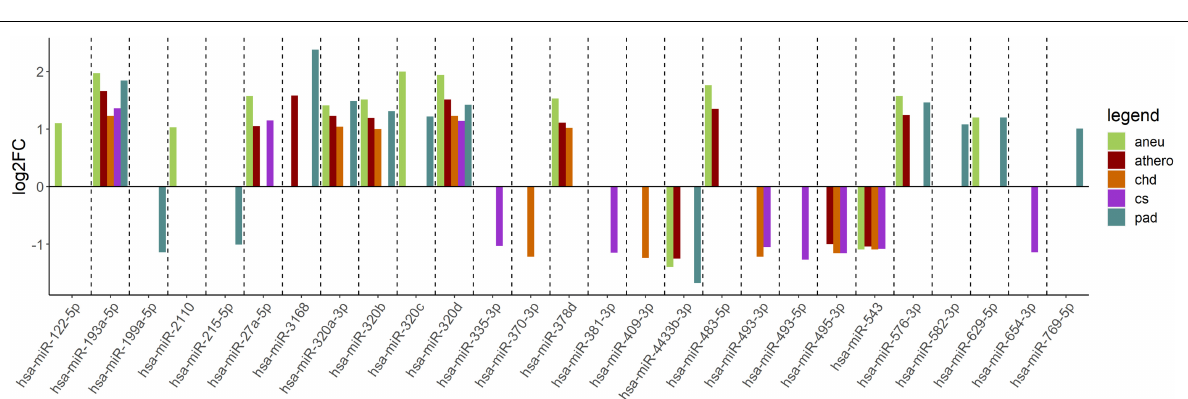
FIGURE 3 | Log2FC of summarized differentially expressed miRNAs from the comparison of each group vs. control. The log2FC is given on the y-axis. aneu = abdominal aneurysm, athero = atherosclerosis, chd = coronary heart disease, cs = carotid stenosis, pad = peripheral artery disease, log2FC = log2 fold